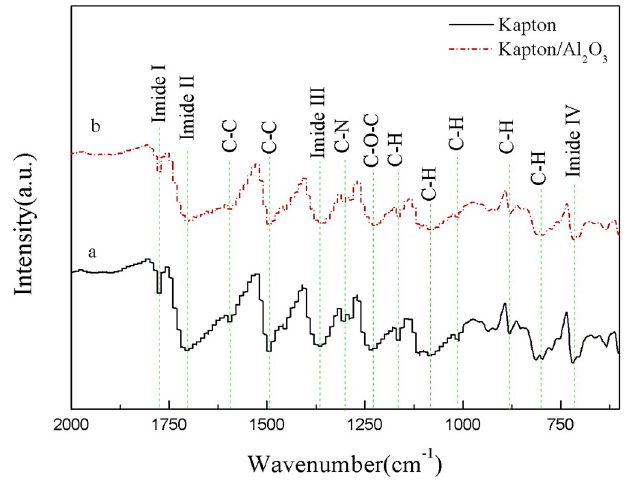
Figure 8. ATR-FTIR spectrum of the Kapton film and the Kapton/Al 2 O 3 surface nanocomposite film.